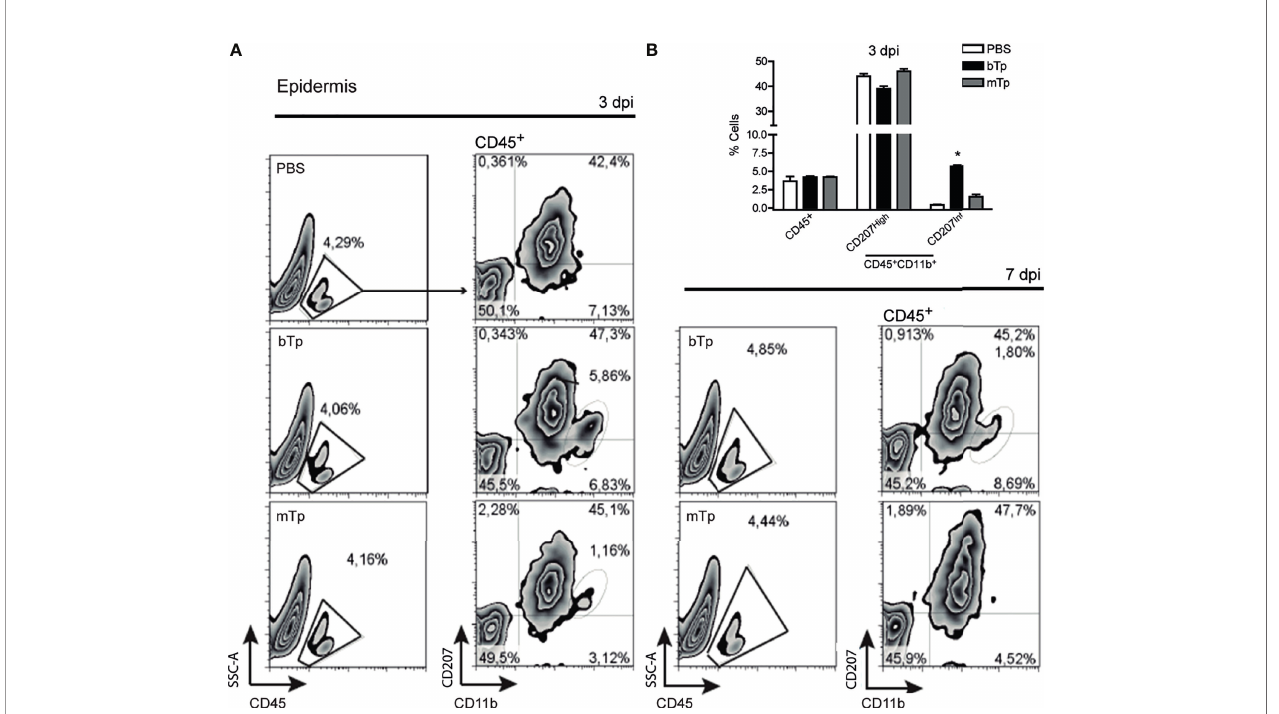
FIGURE 1 | Metacyclic trypomastigote (mTp) or blood trypomastigote (bTp) inoculation recruits different leukocyte populations into the skin. (A) C3H/HeN mice were intradermally injected in the ears with bTp, mTp, or PBS (non-infected; NI). Gating strategy and characterization of leukocyte in fi ltrate in the epidermis at 3 days post- infection (dpi, left panels) and 7 dpi (right panel) analyzed by fl ow cytometry. One representative result of three independent experiments (three biological replicates with two pooled animals per condition) with similar results is shown. (B) Percentage of CD45 + and CD11b + CD207 + cells in skin samples at 3 dpi expressed as the mean + SEM. *p < 0.05 ( N = 3, one-way ANOVA and Bonferroni ’ s